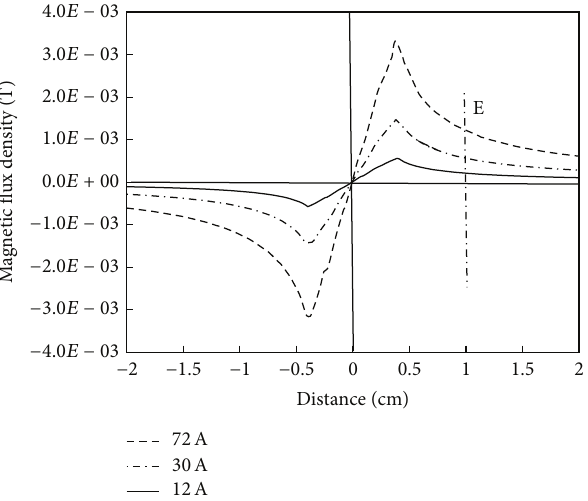
Figure 4: MFD as function of radial distance from the cable’s center (line D in Figure 3).